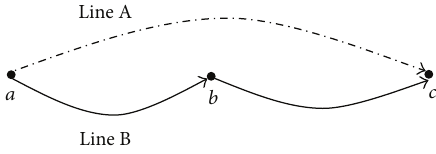
Figure 1: A transit network with two